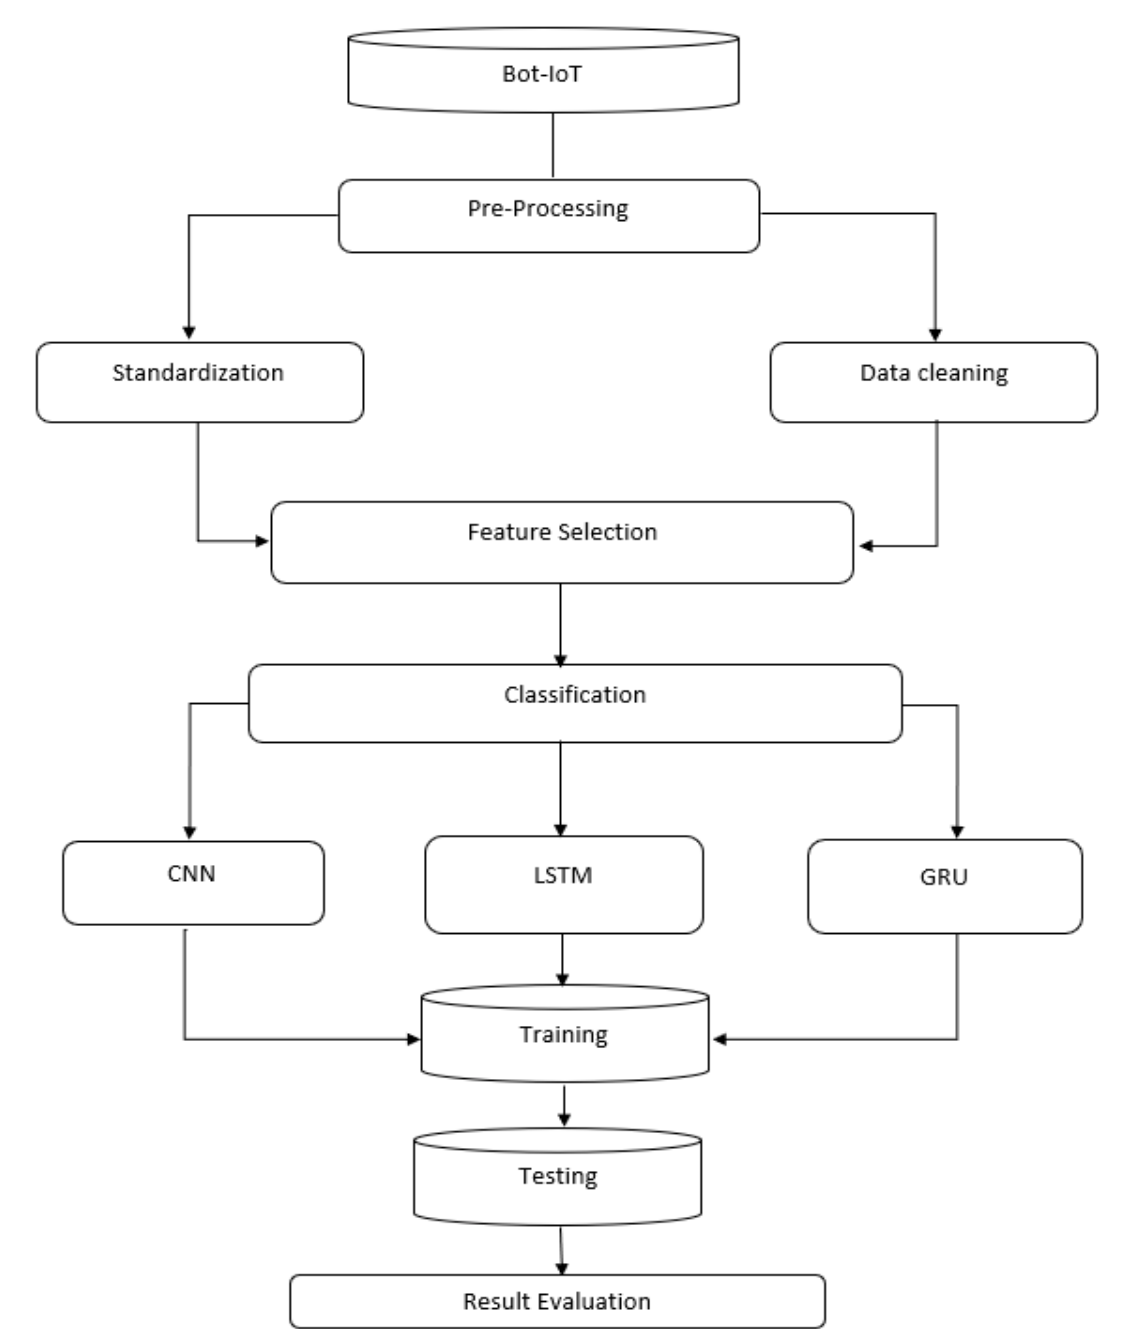
Figure 1. Architecture model.